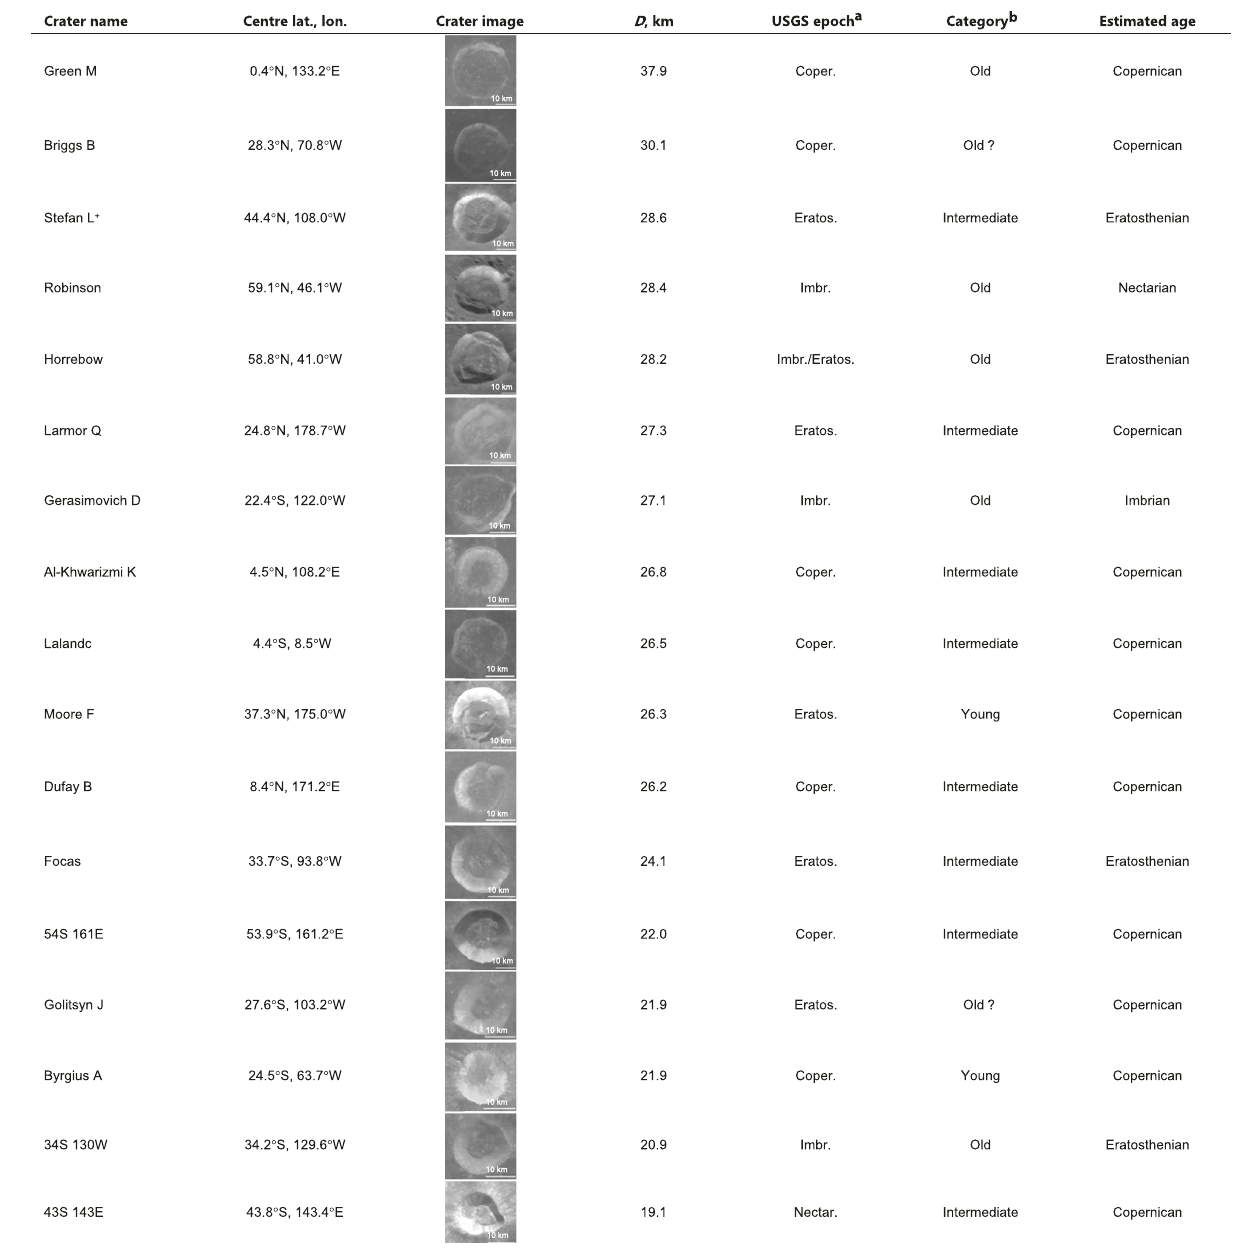
Table 3 Comparison of crater relative ages derived from the optical maturity parameter